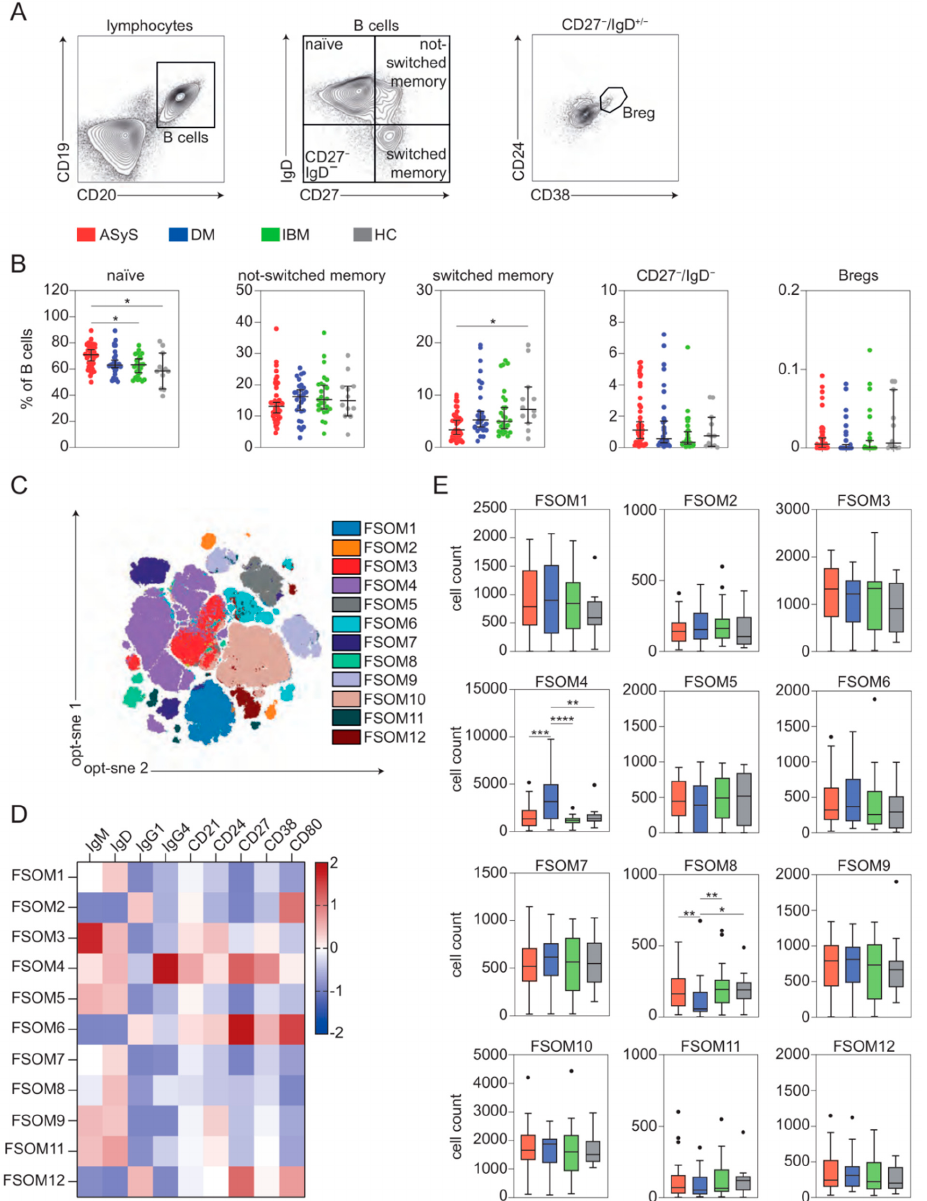
Figure 6. B cell dysregulation is a feature of IIM. ( A ) Representative flow cytometry gating strategy for immune cell subsets. ( B ) Frequencies of indicated B cell subsets. ( C ) Global optimization of tSNE (opt-sne) projection of the B cell population with meta-clusters identified by FlowSOM clustering superimposed. First, flow cytometric markers displayed in ( D ) were entered into opt-sne for generation of a two-dimensional graph of the dataset. Next, the FlowSOM algorithm was applied to the same dataset for unbiased identification of distinct cell clusters. A total of 115 clusters were acquired. Consensus hierarchical clustering identified 12 distinct FlowSOM meta-clusters (FSOM) across these clusters. Each cell visualized in the opt-sne map was labelled to the corresponding FSOM. ( D ) Heatmap displaying mean MFI for indicated FSOM clusters and corresponding marker (column-scaled z-scores). ( E ) Box plots displaying cell numbers of indicated FSOM clusters. Each point represents an individual ASyS (red), DM (blue), IBM (green) patient or healthy controls (grey). Significance was determined by Kruskal–Wallis test: * p < 0.05, ** p < 0.01, *** p < 0.001, and **** p < 0.0001. Abbreviations: ASyS = anti-synthetase syndrome; CM = central memory; DM = dermatomyositis; EM = effector memory; IBM = inclusion body